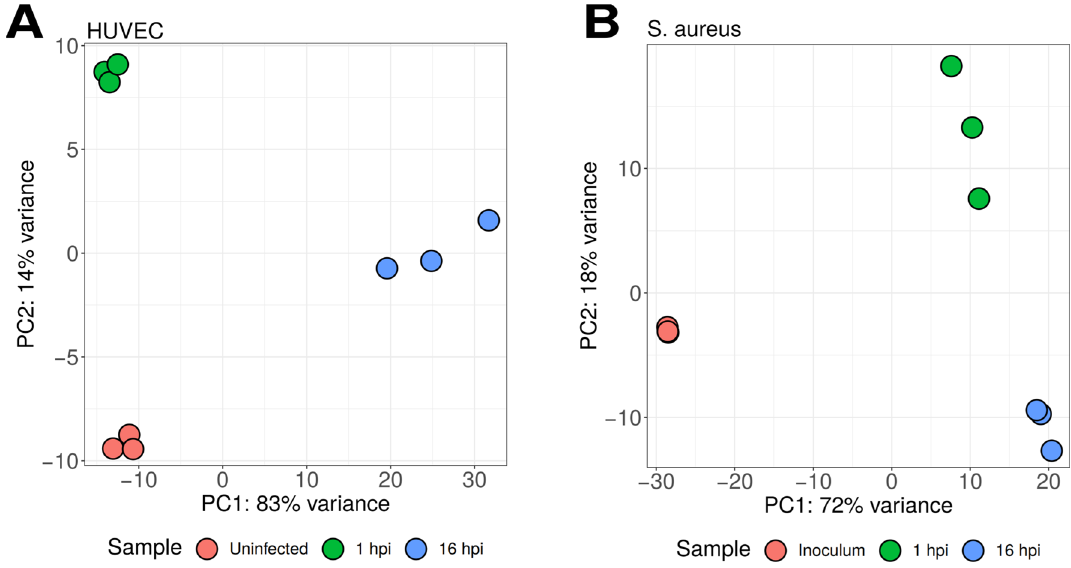
Figure 3. Principal component analysis (PCA) of HUVEC ( A ) and S. aureus ( B ) at different time-points during infection showing clustering into distinct expression profile groups corresponding to each infection